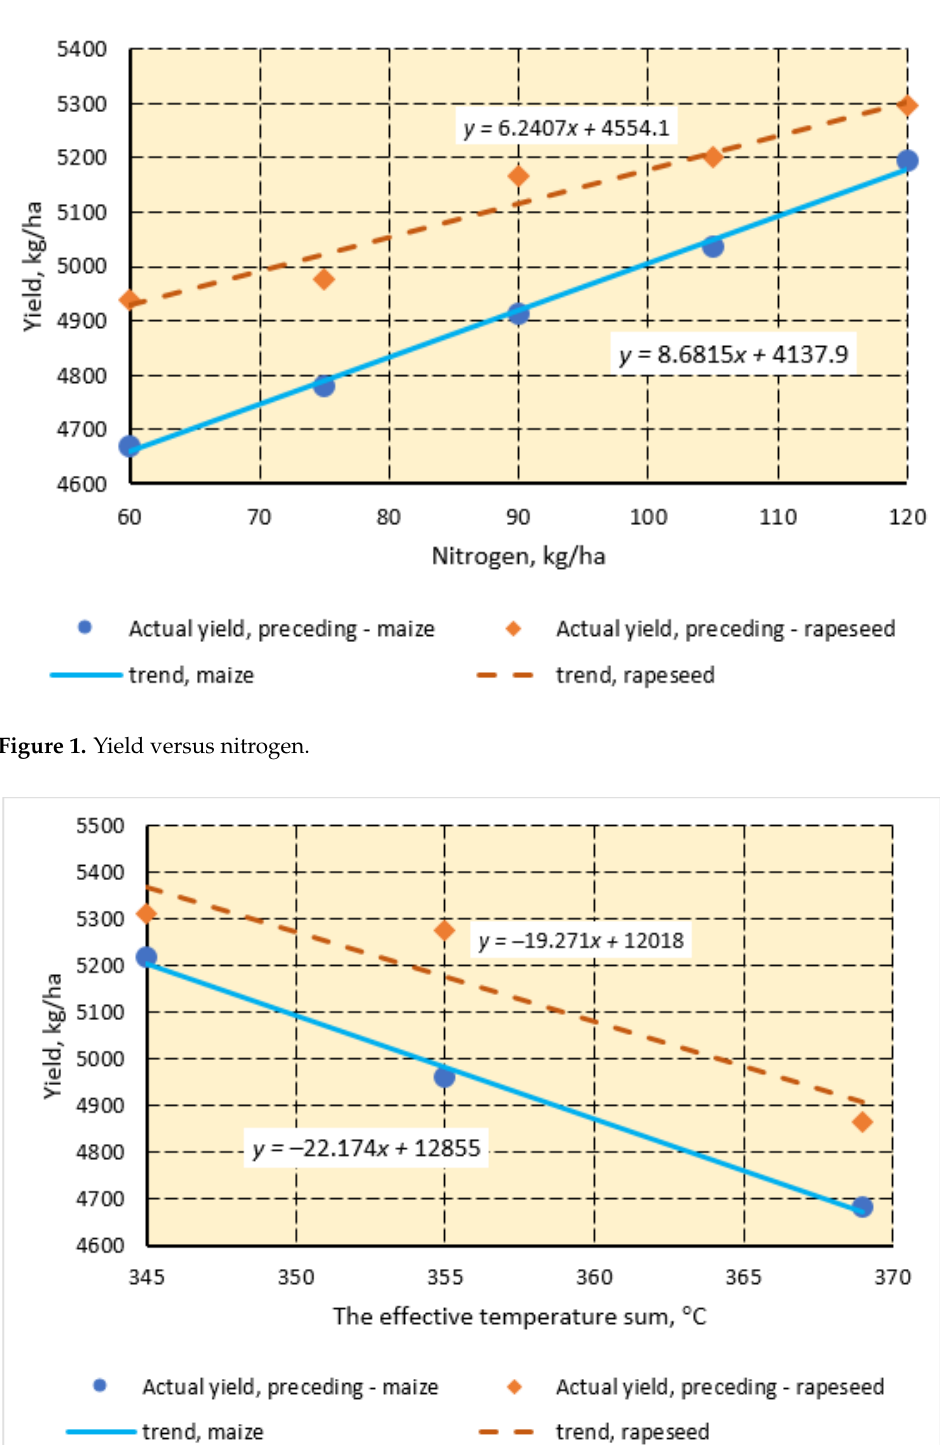
Figure 2. Yield versus the effective temperature sum of the autumn vegetation .